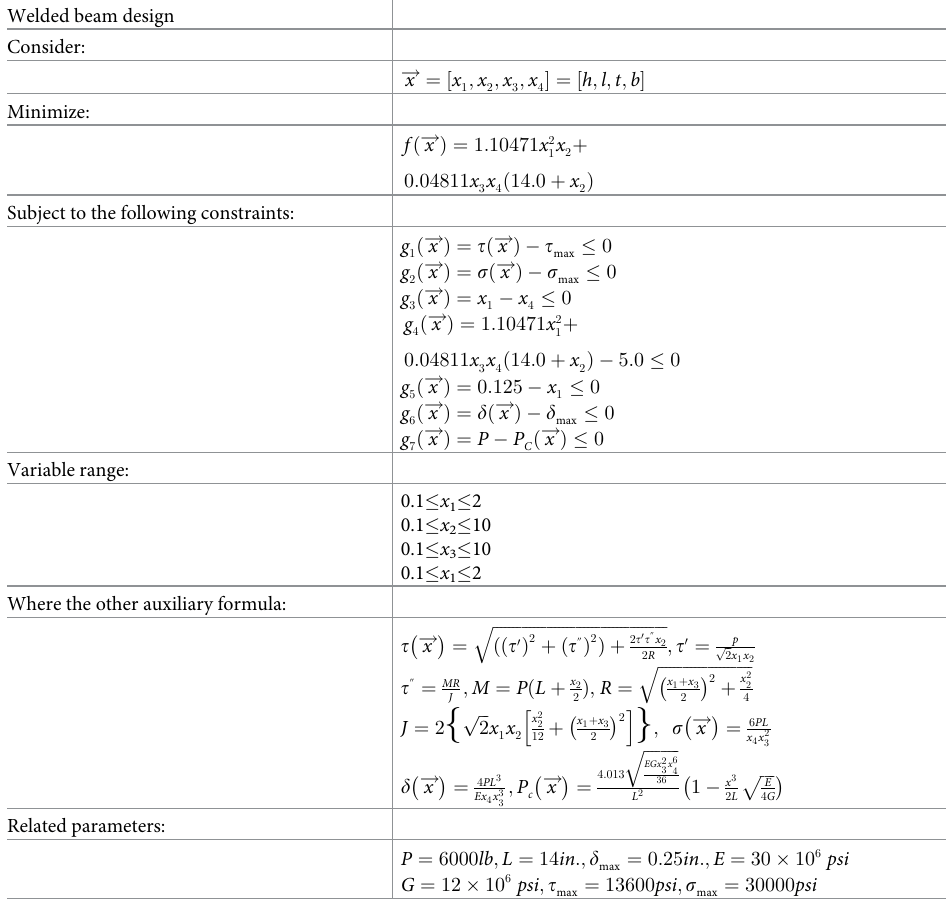
The constraints and problems of the pressure vessel design are shown in Table 9. Many researchers have used different algorithms to solve this design problem, such as MFO [31], MVO [33], GA [34], HS [35], etc. Table 10 gives a comparison of the best solutions so far obtained through MSA and other algorithms, which have previously been reported in the liter- ature on pressure vessel design problems, and the MSA has found the lowest cost design.